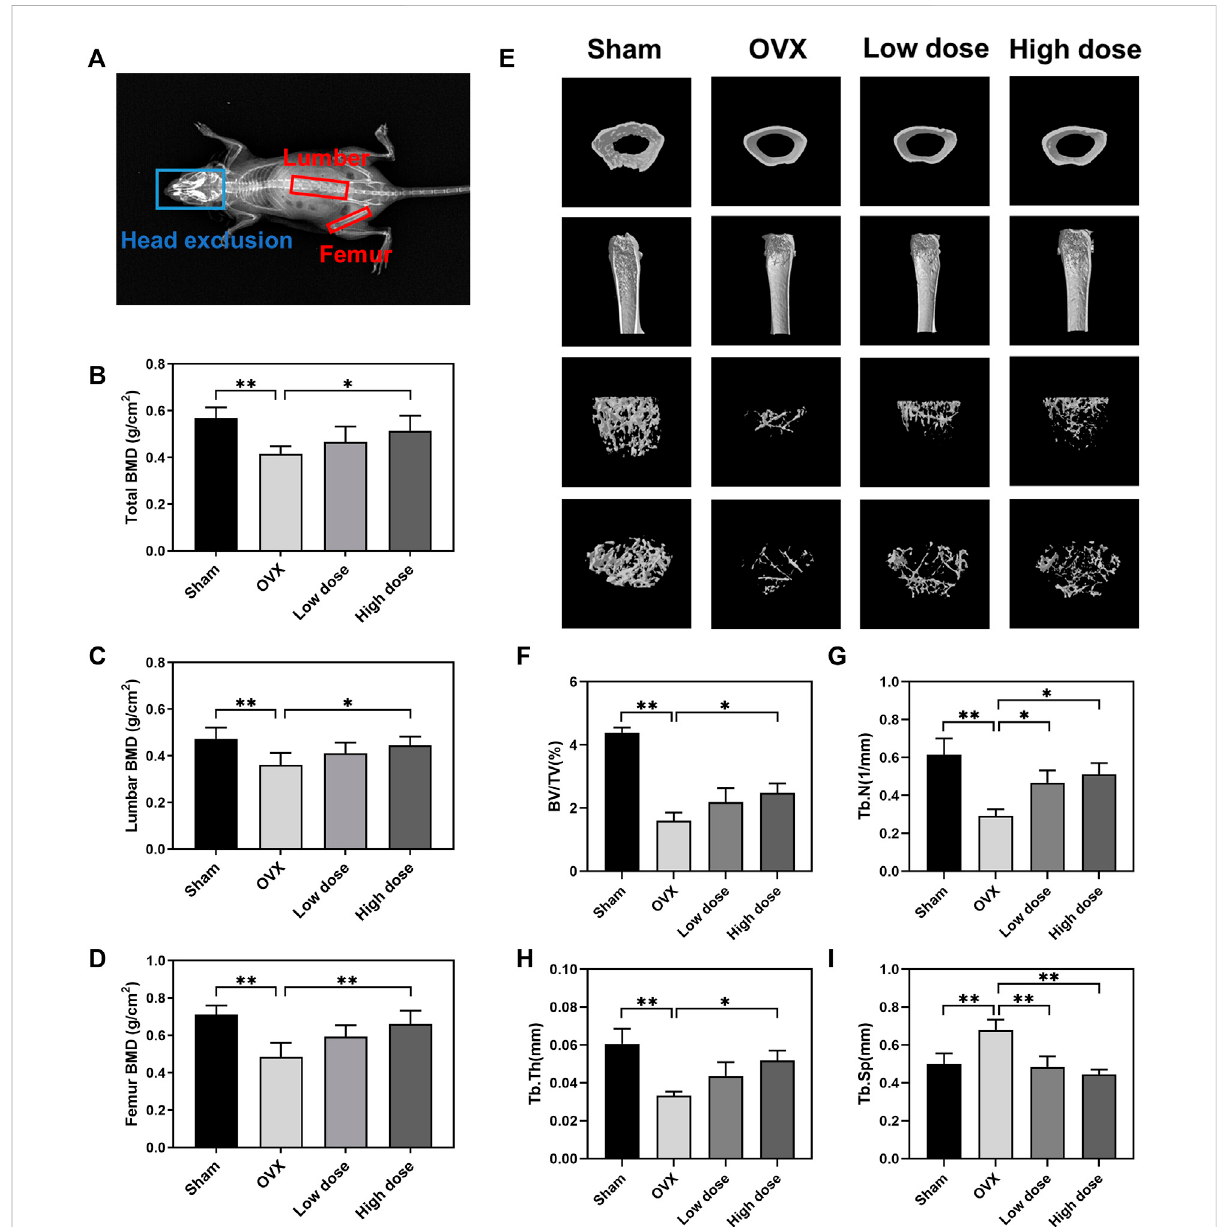
FIGURE 5 BBM suppresses bone loss in ovariectomized mice. (A) Schematic of the BMD analysis using DXA. (B – D) Quantitative analysis of the total BMD (B) , lumbar BMD (C) and femur BMD (D) of mice. (E) Representative μ CT 3D-reconstructed images of distal femurs. (F – I) Quantitative analysis of the trabecular bone in the distal femur metaphysis, including BV/TV (F) , Tb.N (G) , Tb.Th (H) and Tb. Sp (i). * p < 0.05 and ** p < 0.01 compared to the OVX